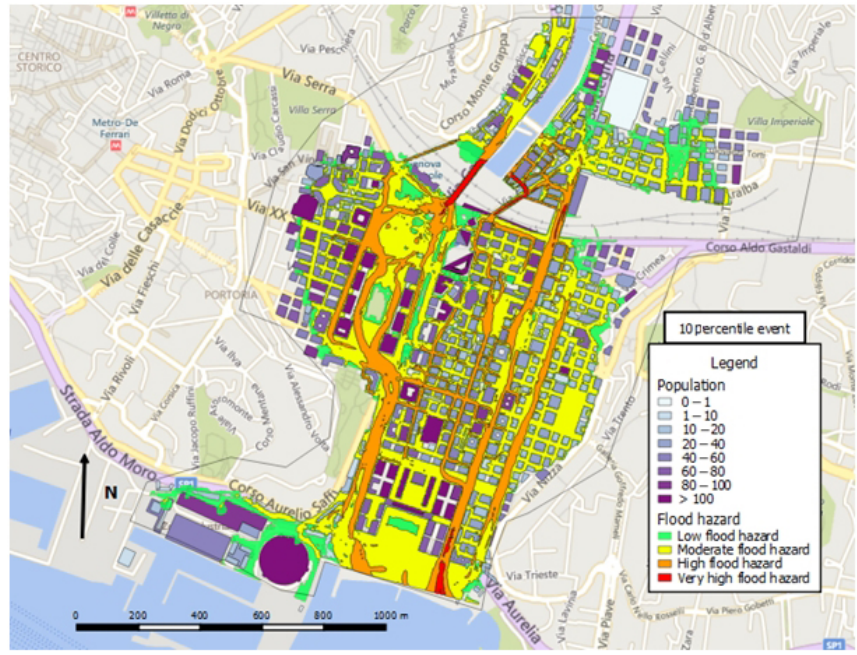
Figure 12. Perc10 scenario, hazard level map compared with population potentially involved assigned to each building.